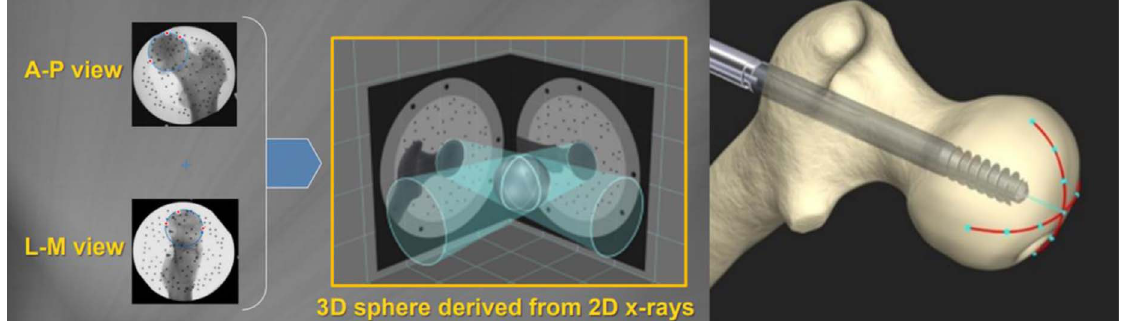
Figure 2. Principle: A 3D model is constructed by analyzing position markers obtained from 2D X-ray images in two directions. Concept of TSD : TSD is the distance from the tip of the screw to the surface of the femoral